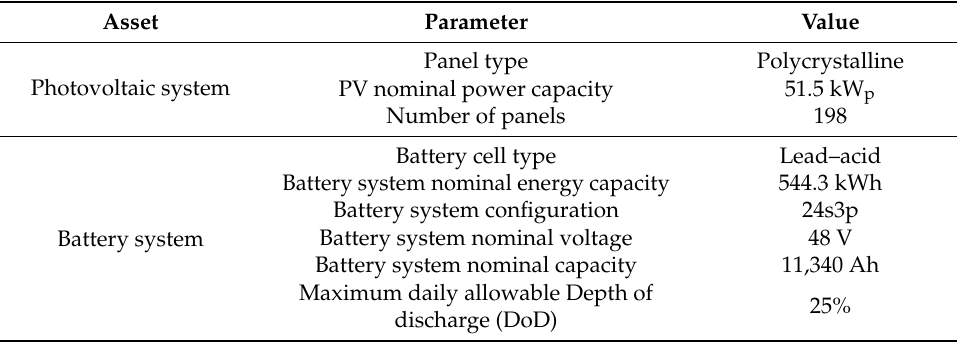
Table 2. Main parameter values of the electrical